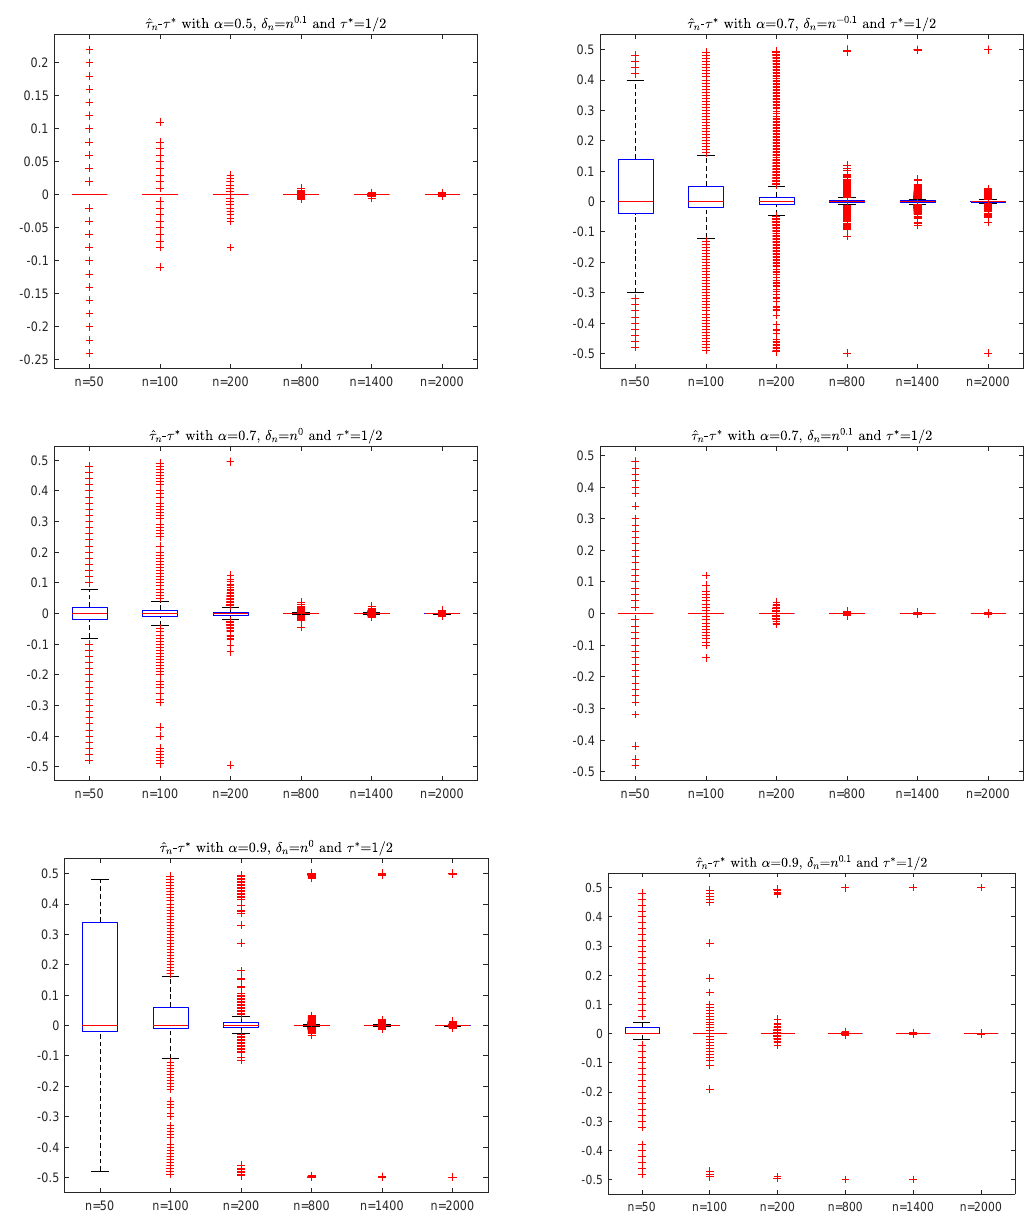
Figure 1. The box plots of ˆ τ n ( α ) − τ ∗ with different α and δ n